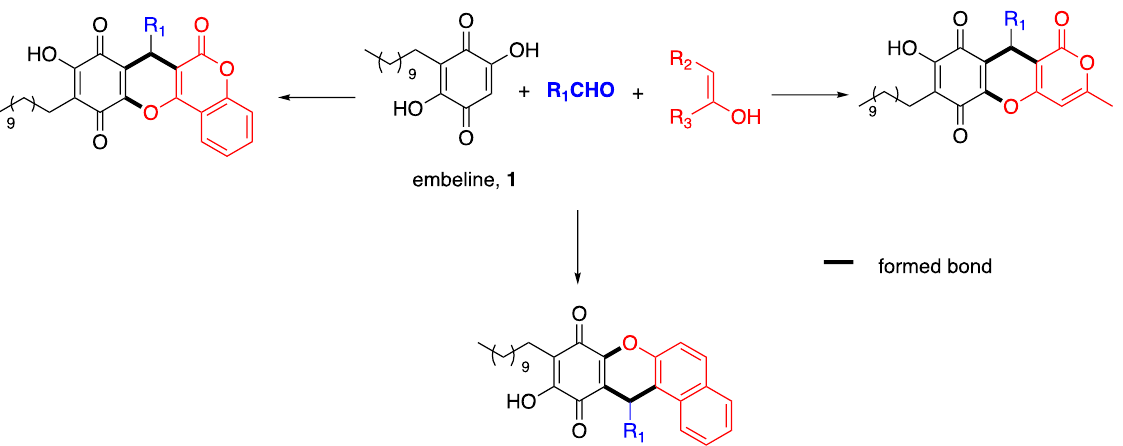
Figure 1. Location and highest value of the Fukui function ( f k − ) for compounds ( 1 – 4 ).